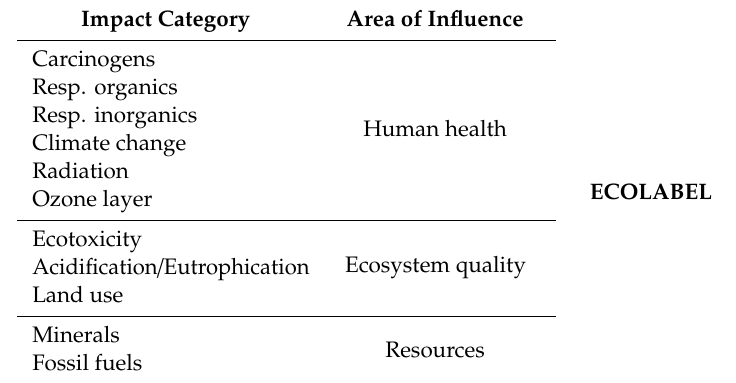
Table 1. Data aggregation method in the method Eco-indicator